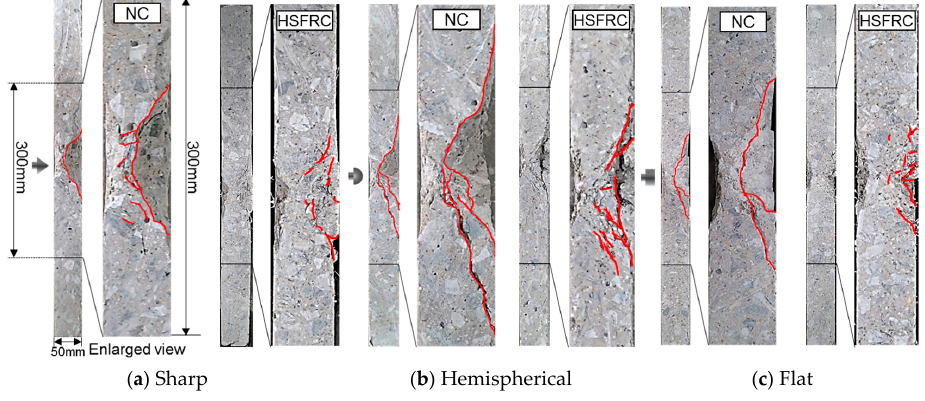
Figure 9. Cross section of the concrete panel (thickness 50 mm).